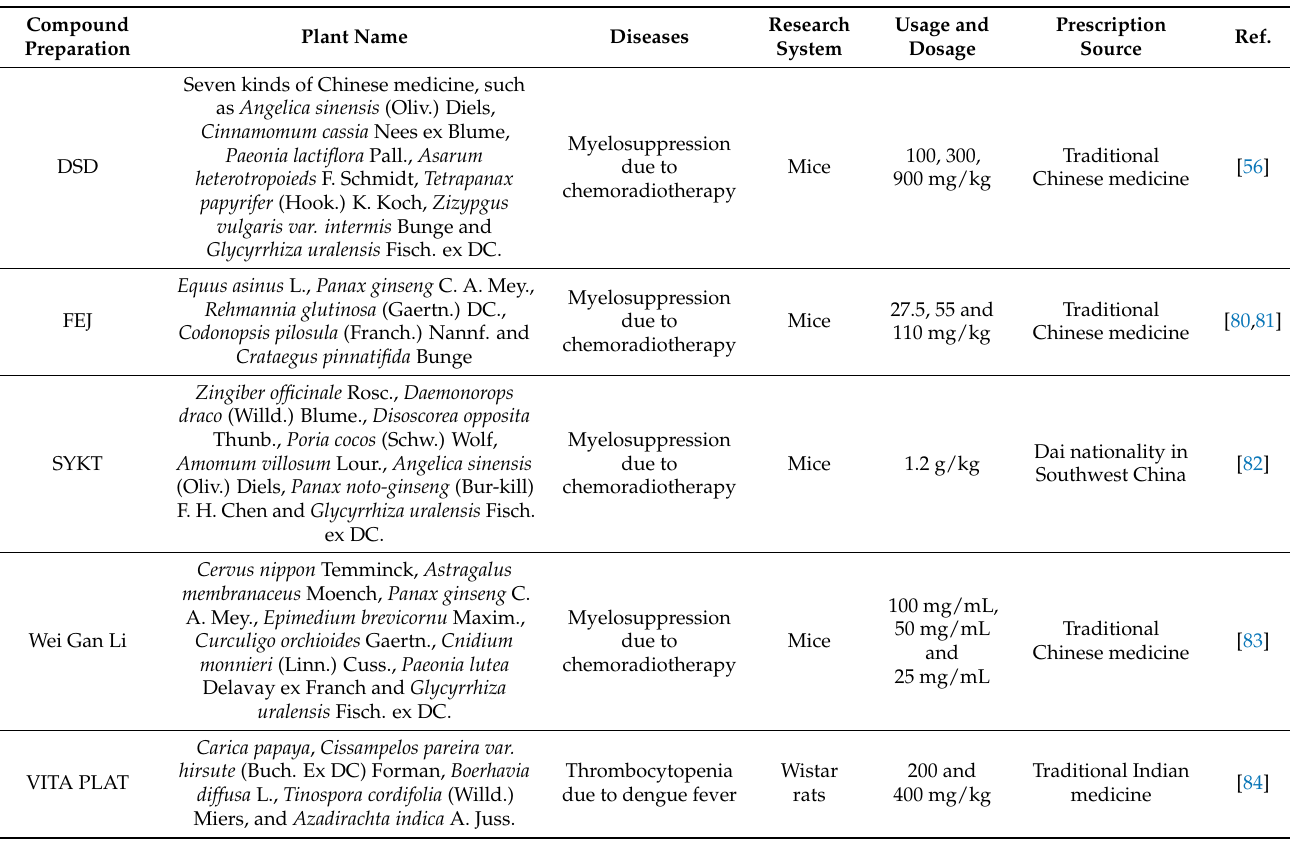
Table 2. Plant drug species, associated diseases and prescription sources of the compound preparation in